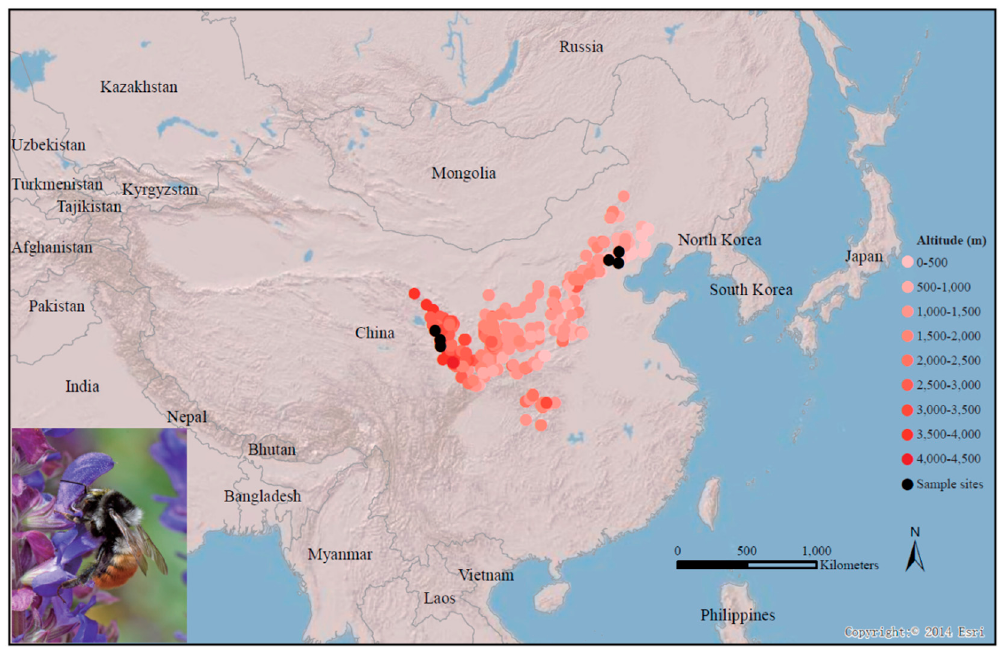
Figure 1. Relief map of China’s mainland showing the recorded distribution (red dots) and the sampling sites (black dots) of B. pyrosoma sequenced in this study. The black dots show the three sites (ranging from 522 to 905 m altitude) in the low-altitude North China Plain and the three sites (ranging from 3524 to 3896 m altitude) in the high-altitude Tibet Plateau. The international boundaries are shown in gray, with the names of countries in black. The map was created with ArcGIS v 10.0.